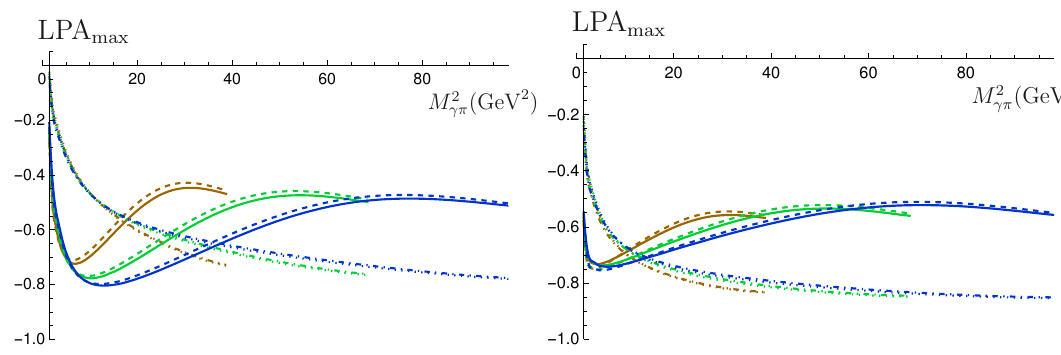
on γπ = 80 , 140 , 200 GeV 2 . The γN